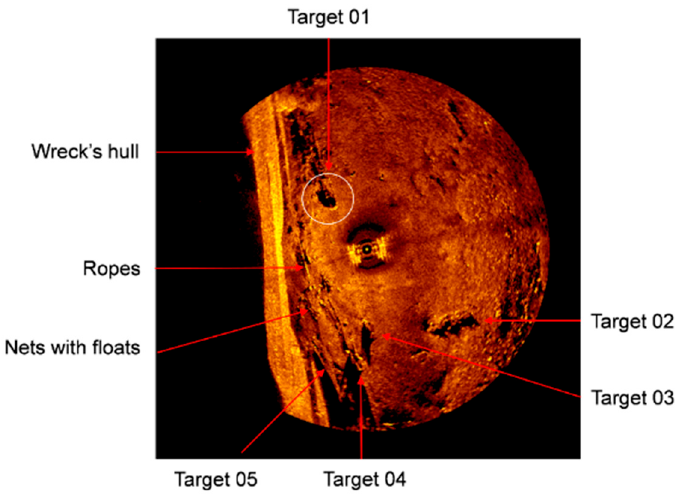
Figure 19. Sonar imaging of the seabed near the wreck, a depth of 87 m.